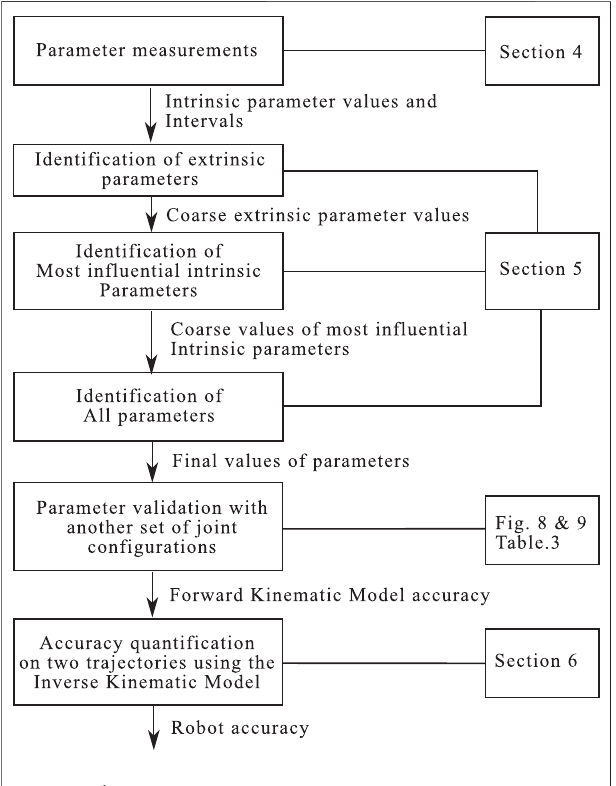
FIGURE 6 | Flowchart of the parameter identi fi cation